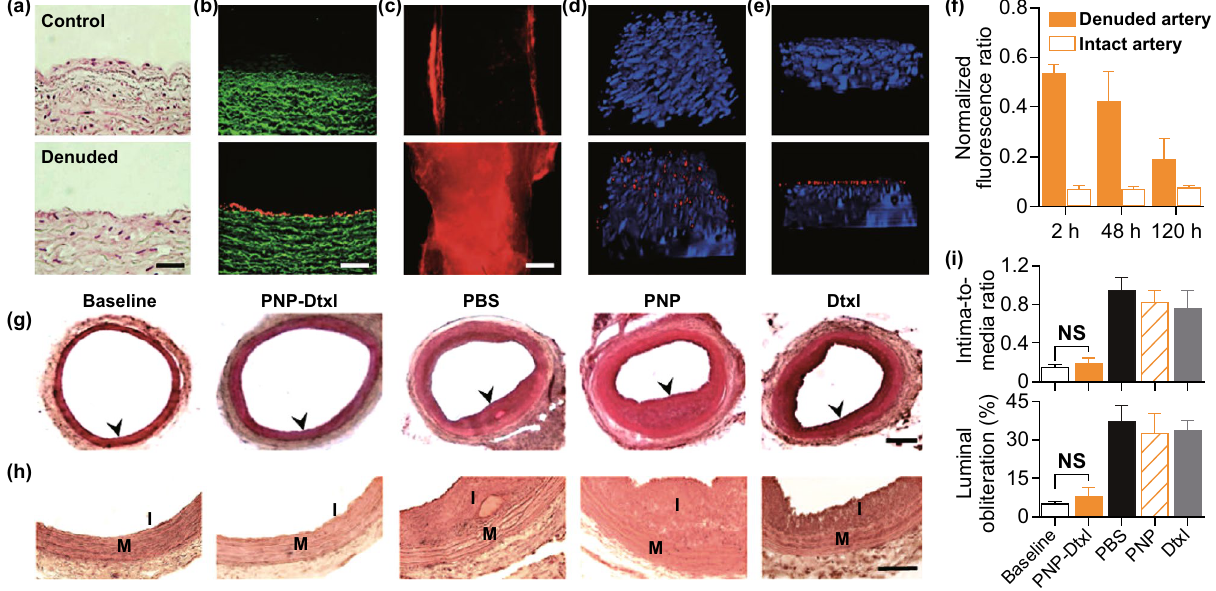
Fig. 6 a H&E‑stained human carotid arterial cross‑sections from intact (upper) or injured (lower) samples. Scale bar = 200 μm. b Fluorescence imaging of cross sections (scale bar = 200 μm) and c luminal side (Scale bar = 500 μm) of intact (upper) or injured (lower) arterial tissue (in green) following incubation with PNPs (in red). d – e 3D reconstructions based on multiple section images from either undamaged (upper) or balloon‑denuded (lower) rat arterial walls following i.v. PNP delivery, with nuclei stained blue and PNPs in red; 152.5 × 116 × 41 μm 3 . f PNP retention in denuded and undamaged arterial sites for 120 h following PNP administration ( n = 6). g Representative arterial cross‑sections from coronary restenosis model rats exposed to different treatments. Scale bar = 200 μm. h Magnified cross‑sections highlighting differences in vas‑ cular remodeling among groups; I, intima; M, media. Scale bar = 100 μm. i Quantification of the intima‑to‑media area ratio and luminal oblitera‑ tion in differently treated animals ( n = 6). Data are mean ± S.D. NS, no significant difference. Adapted from Ref. [111] with